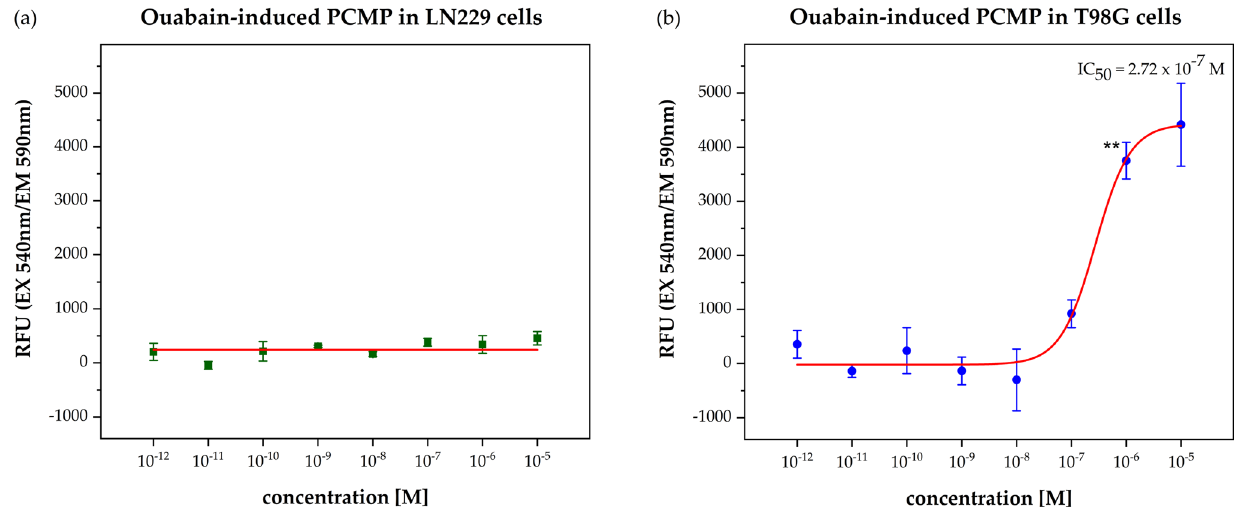
Fig. 3 Plasma cell membrane potential (PCMP) assay with cell line LN229 ( a ) and T98G ( b ). The relative fluorescence units (RFU) were plotted as the function of the Ouabain concentration (10 –12 to 10 –5 M). Fluorescence values of the solvent control was defined as background and was subtracted from all single values. Results are shown after a treatment period of 4 h. The red curves represent the nonlinear regression analysis for the IC calculation. The significant concentration-dependent fluorescent change was only observed for the TMZ-resistant cell 50 line T98G by IC = 2.72 × 10 –7 M, which showed a clear depolarization of the plasma cell membrane. Error bars show the range of each dupli- 50 cate and the level of significance is shown by the p-value range ( ** p < 0.01) Fig. 4 Correlation between plasma cell membrane poten- tial and cell migration in the cell line T98G. The red curves represent the linear regression analysis for the Ouabain con- centration (10 –12 to 10 –5 M) with the coefficient of deter- mination (R 2 = 0.95) based on Pearson